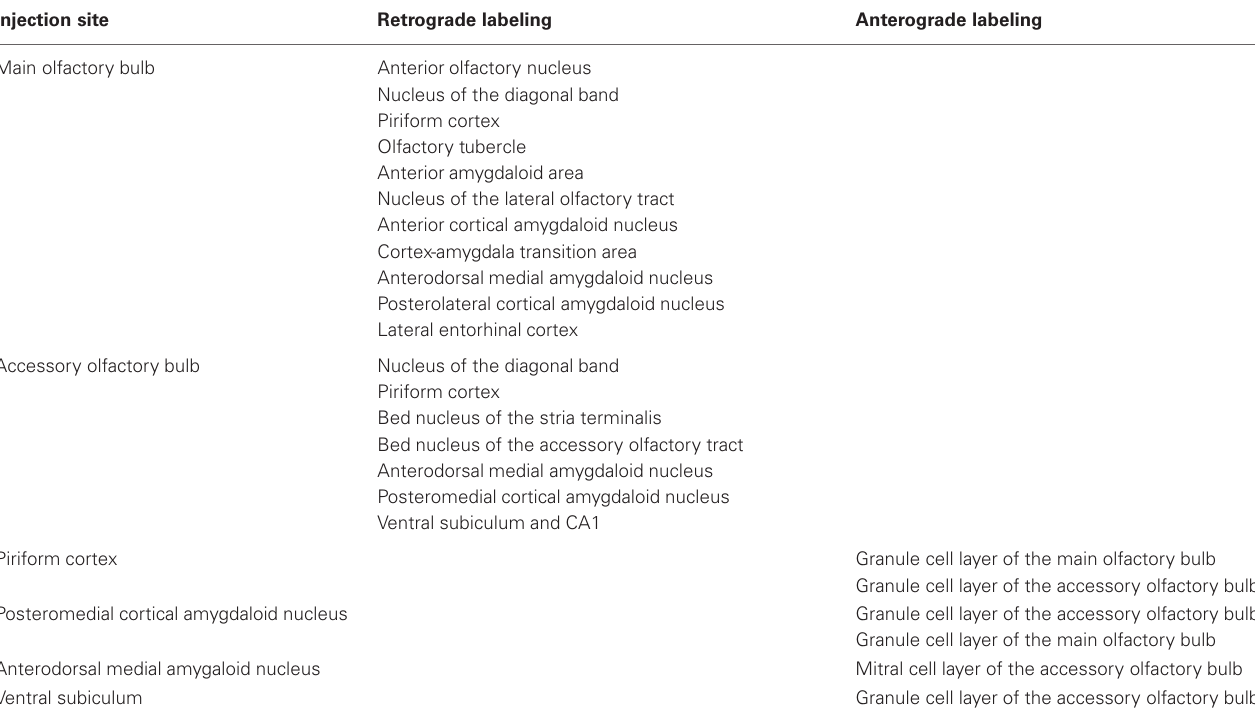
Table 1 | Summary chart of main